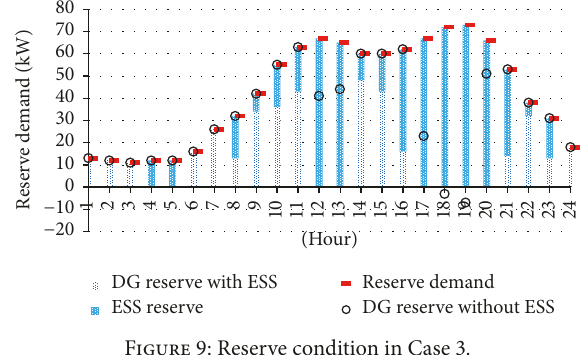
Figure 9: Reserve condition in Case